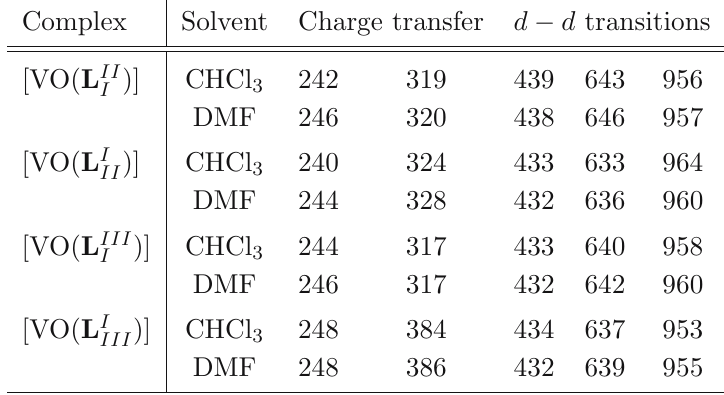
Table 2 Electronic spectral data for vanadium(IV) complexes ( λ